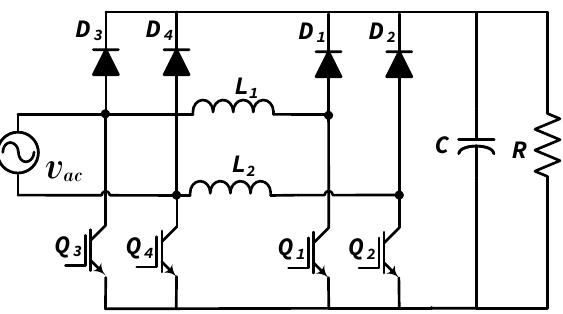
Figure 12. Semi-bridgeless topology with clamped diodes and switches.